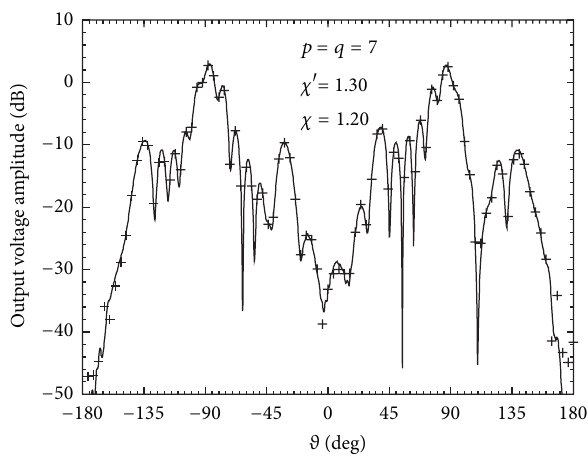
Figure 15: Amplitude of 𝑉 on the meridian at 𝜑 = 0 ∘ . Solid line: measured. Crosses: recovered from NF data acquired via the spherical spiral scanning.